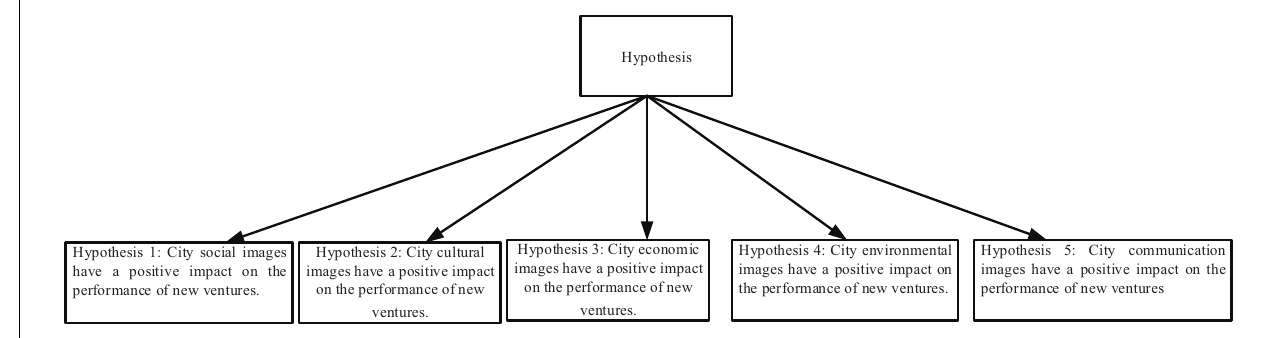
FIGURE 1 | The hypotheses